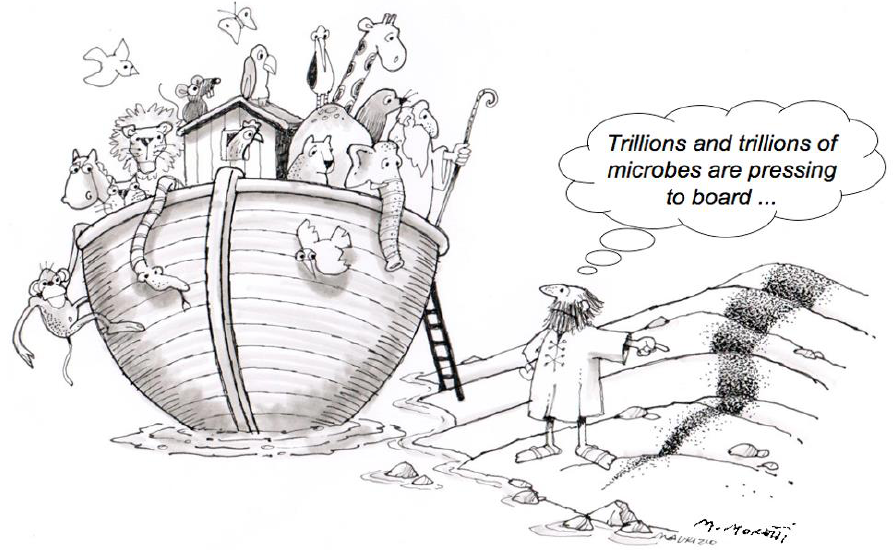
Figure 1. The everlasting relationship between microbes and their host. An interpretative artwork by the artist Maurizio Moretti.